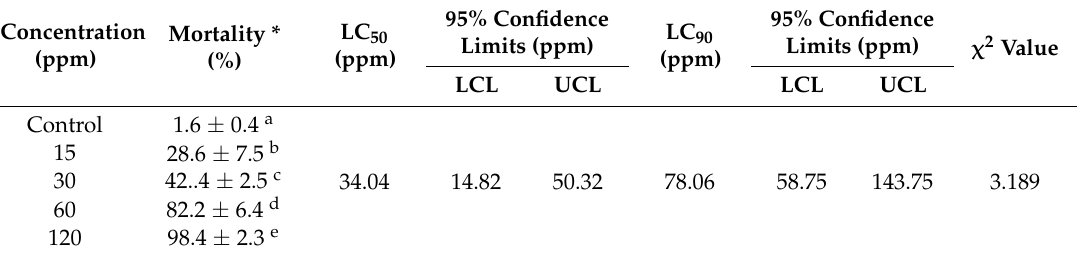
Table 1. Larvicidal activity of synthesized ZnO NPs.